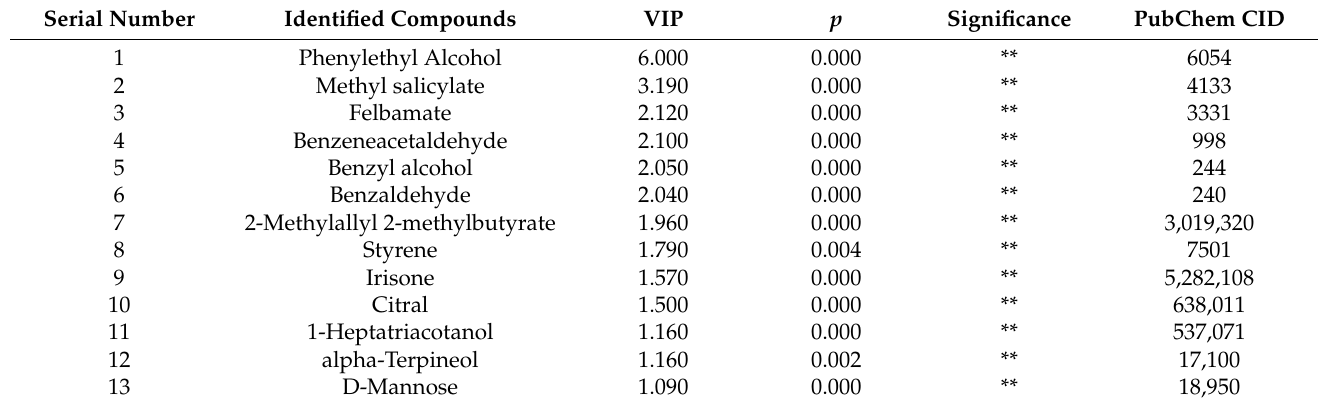
Table 3. Results of screening potential differential metabolites of cherry tomatoes with varying